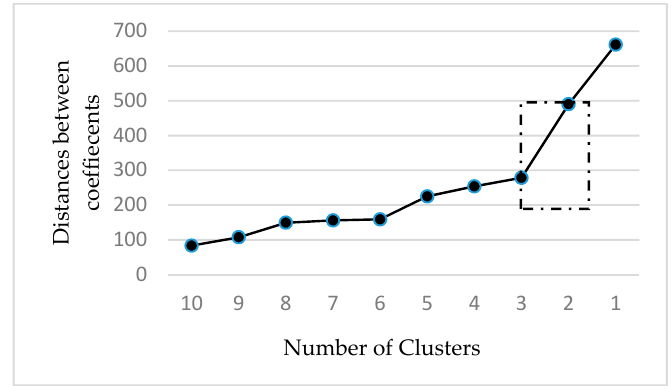
Figure 1. Analysis of the coefficients from the agglomeration schedule .